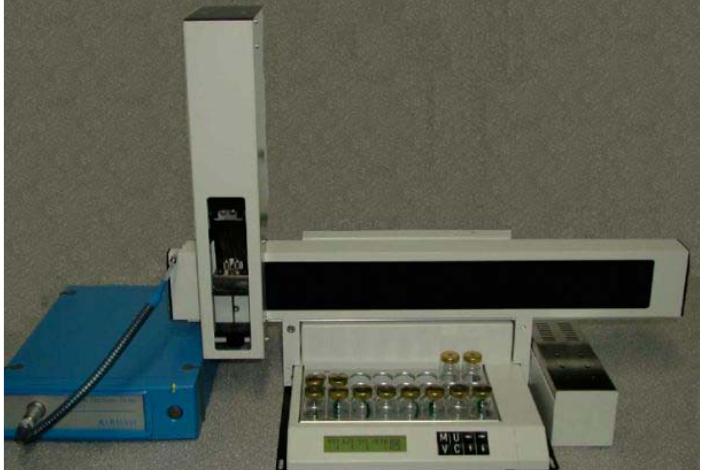
Figure 1. Airsense HSS32 autosampler connected to the portable electronic nose